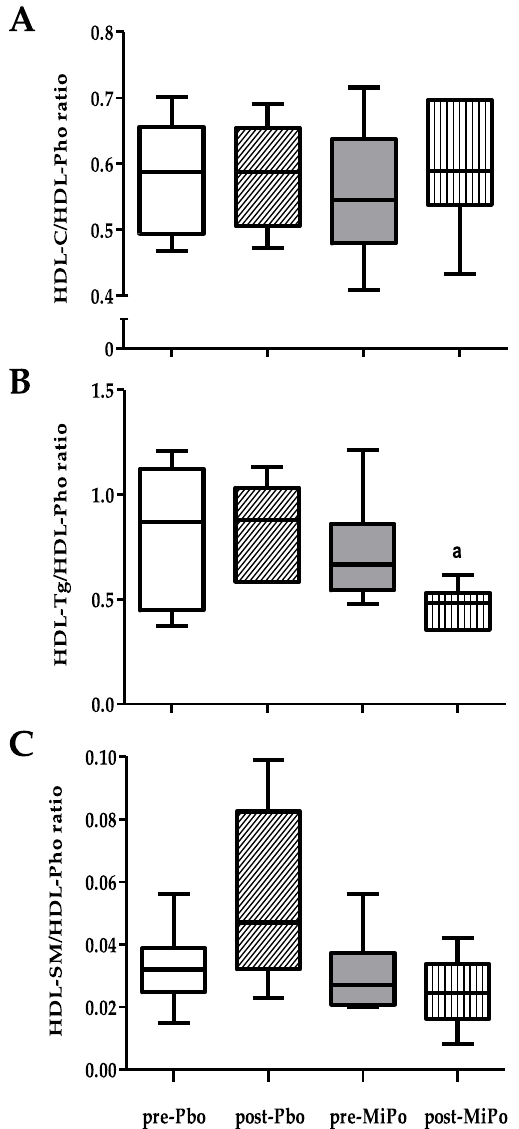
Figure 1. Lipid plasma concentration ratios of HDL. The ratios were calculated in both MiPo and placebo groups, before (pre-) and after (post-) of 30 days of supplementation with MiPo or administration with maltodextrin as placebo (Pbo). ( A ) HDL-cholesterol-to-phospholipids ratio. ( B ) HDL-triglycerides-to-phospholipids ratio. ( C ) HDL-sphingomyelin-to-phospholipids ratio. Data are expressed as median (horizontal lines) and interquartile range (boxes). Mann–Whitney U test. a p < 0.05 Baseline (pre-) vs. after 30 days of supplementation with MiPo (post-).